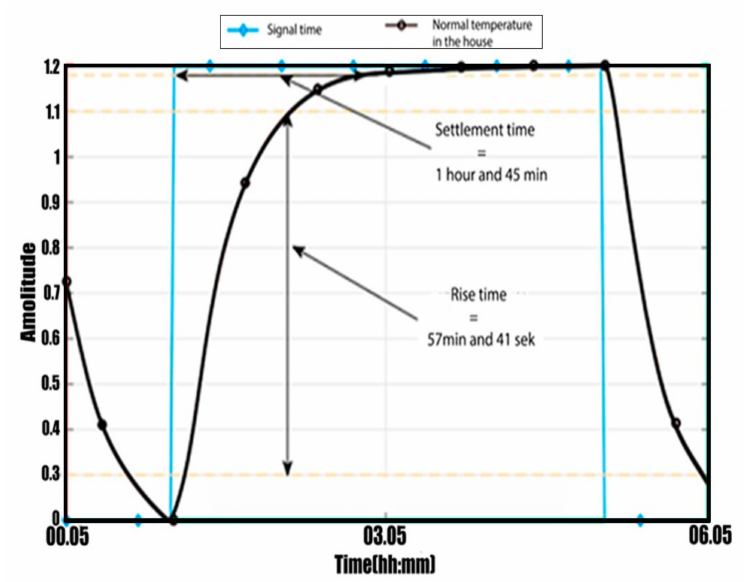
Figure 12. Step-by-step response of the dynamic